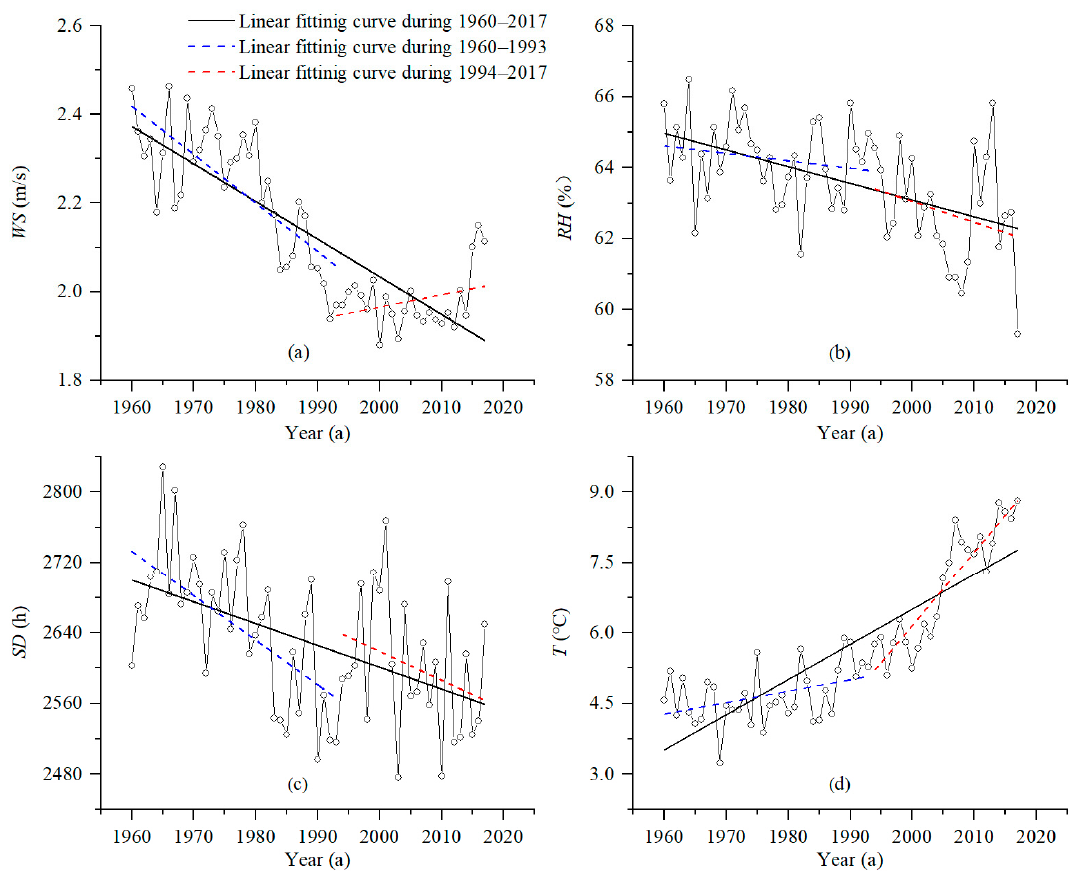
Figure 3. Interannual variations of climatic factors in Northeast China. ( a ) WS , ( b ) RH , ( c ) SD , and ( d ) T .